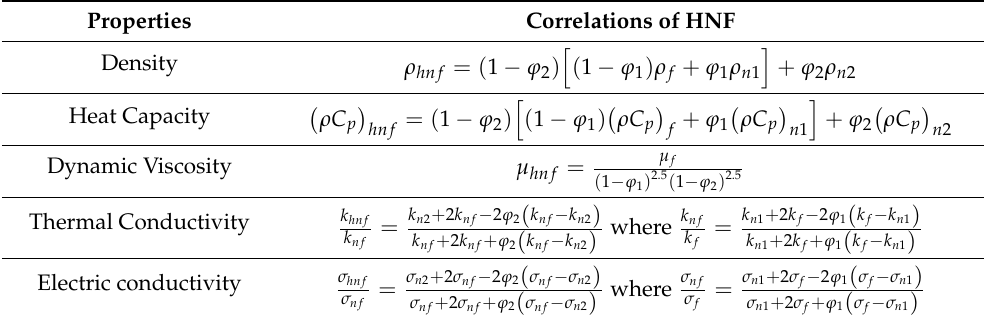
Table 2. Correlations of HNF (referring to Waini et al.